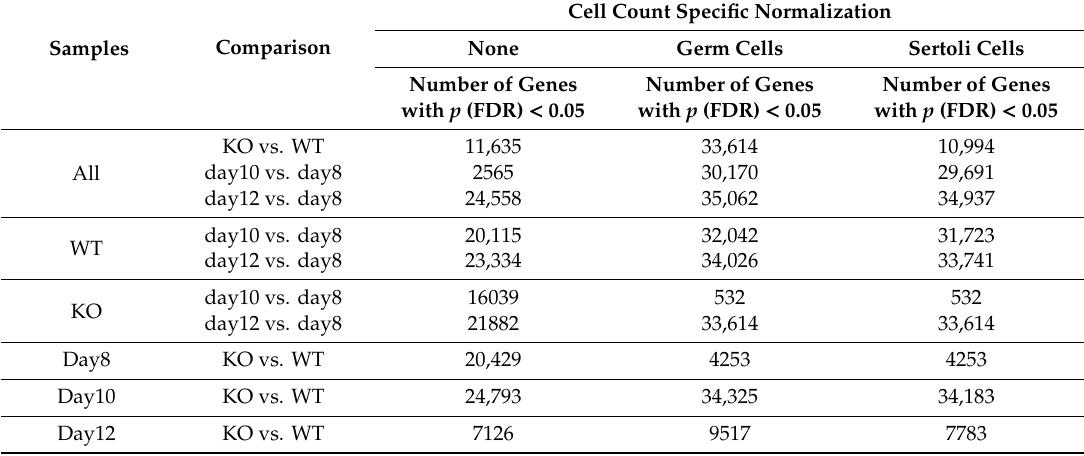
Table 4. Number of di ff erentially expressed genes for each comparison with respect to the type of